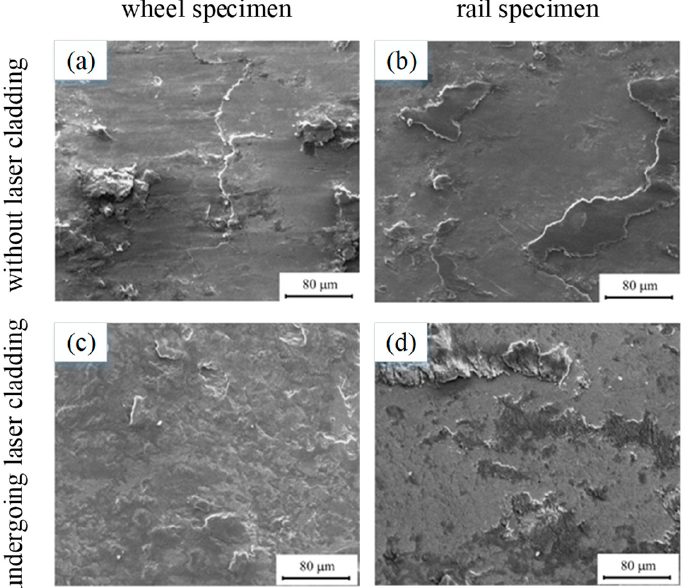
Figure 5. SEM morphologies of ( a ) wheel and ( b ) rail specimens without laser cladding (25 t), ( c ) wheel and ( d ) rail specimens undergoing laser cladding with common Co-based alloy powders (Reprinted from Ref. [31], copyright (2014), with permission from Elsevier).